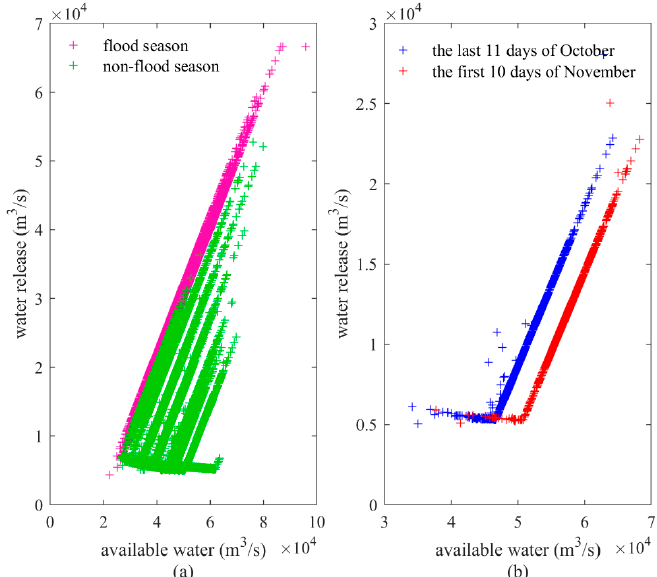
Figure 8. Scatter plots of optimal water release versus available water ( I i , j + V i , j / ∆ t plus signs and green plus signs denote the correlation between optimal water release and available water during flood season and non-flood season, respectively. ( b ) The blue plus signs denote this correlation during the last 11 days of October and the red plus signs denote this correlation during the first 10 days of November.